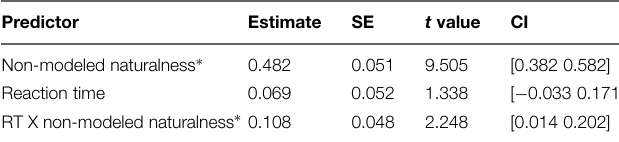
TABLE 3 | Results of the regression of esthetic preference on modeled perceived naturalness, RT, and their interaction. Predictor